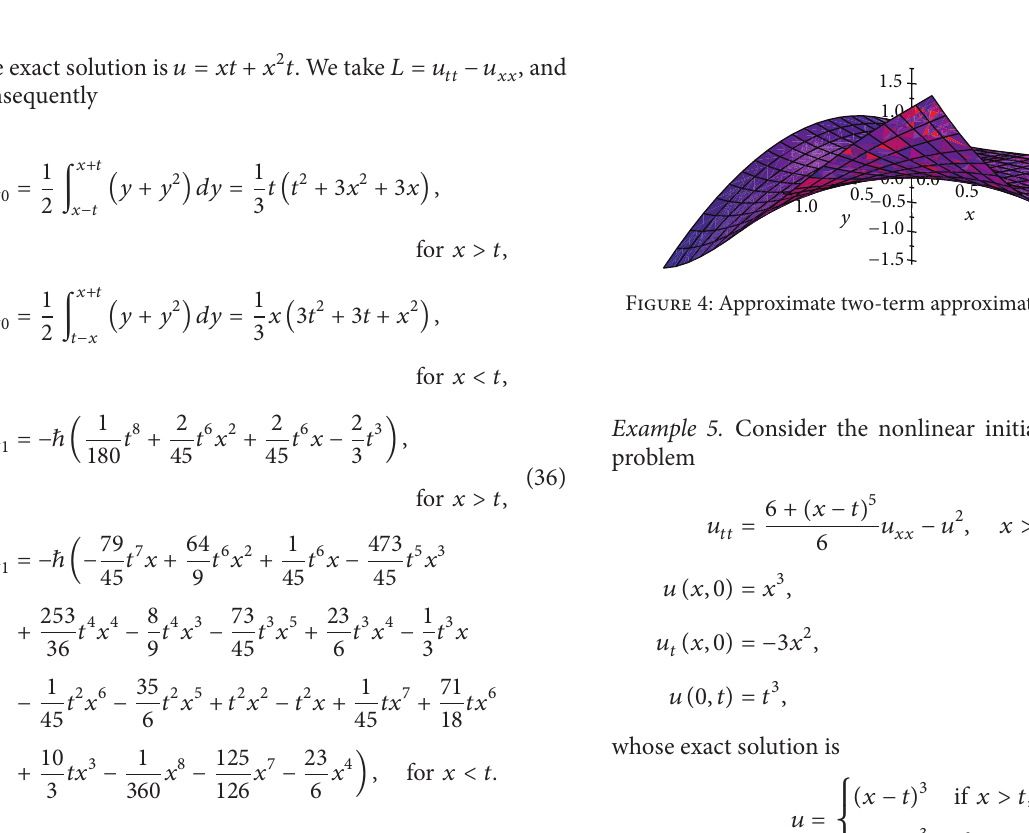
Figure 3: Exact solution for Example 4.